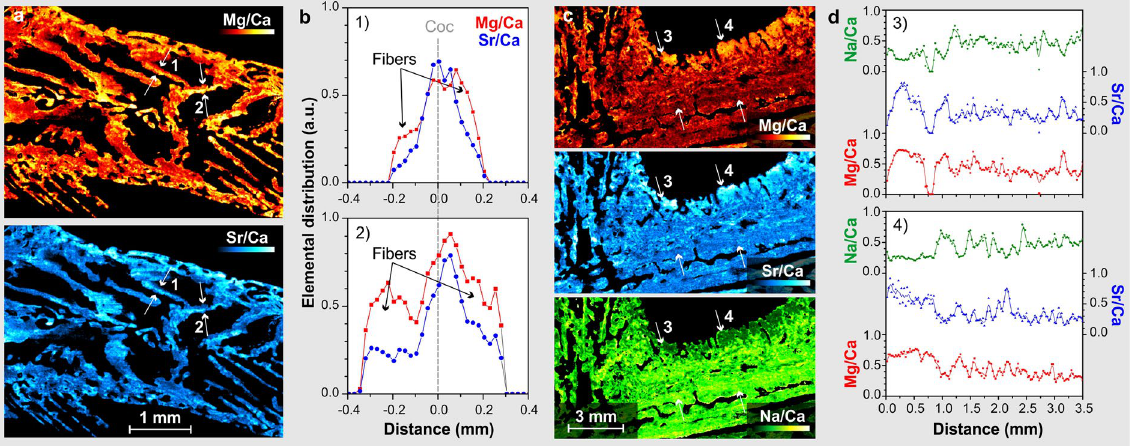
Figure 6. ( a ) Elemental images (Mg/Ca, Sr/Ca) of Dendrophyllia in the region represented by rectangle (1) in Fig. 5, which shows COC transects where fibres are located ( b ); ( c ) elemental images (Na/Sr/Mg) of the region represented by rectangle (2) in Fig. 5, with transverse profiles ( d ) across the coenosteum. Both images ( a ) and ( b ) has been tilted by 90° for better